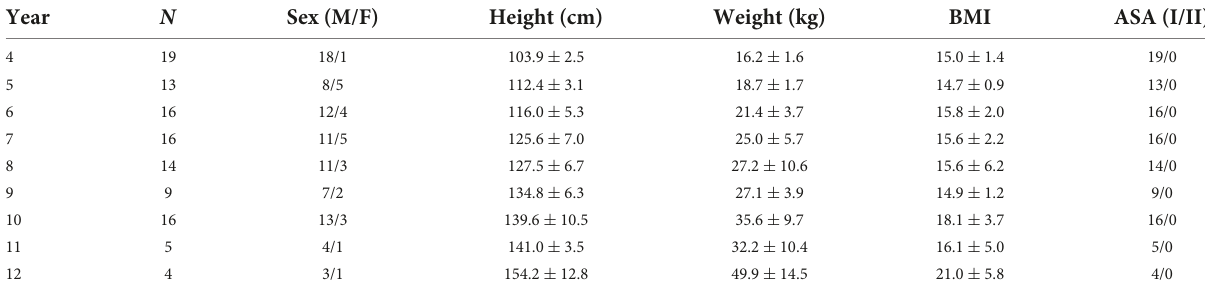
TABLE 2 Characteristics of 112 subjects based on age